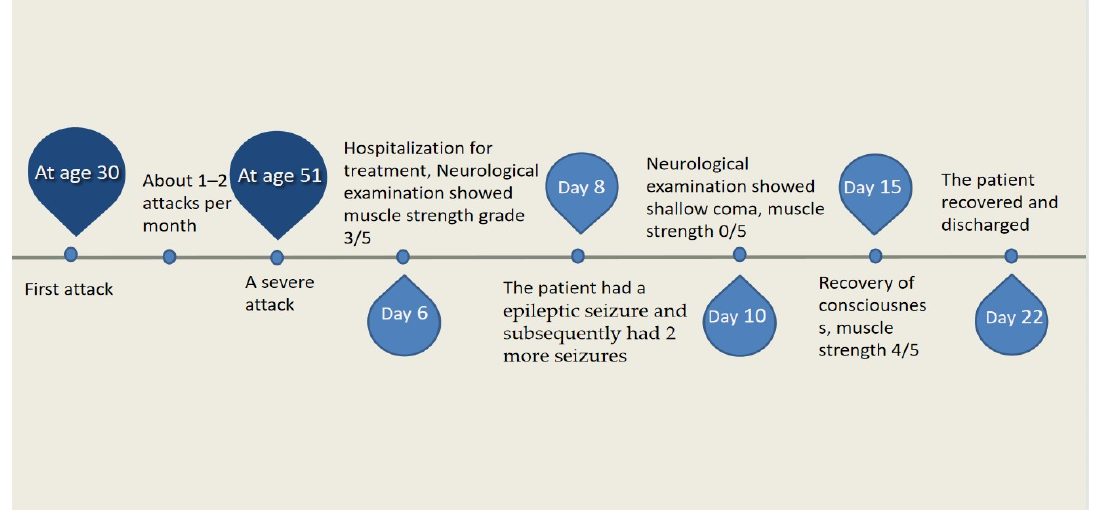
Figure 3. Time course of the disease. Diagram illustrating time course of disease in our patient.